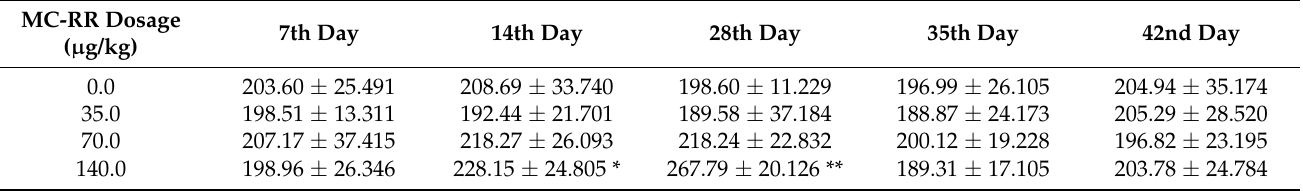
Table 7. Antidiuretic hormone (ADH) levels of KM mice in continuous exposure experiment (mean ± SD, n = 7).